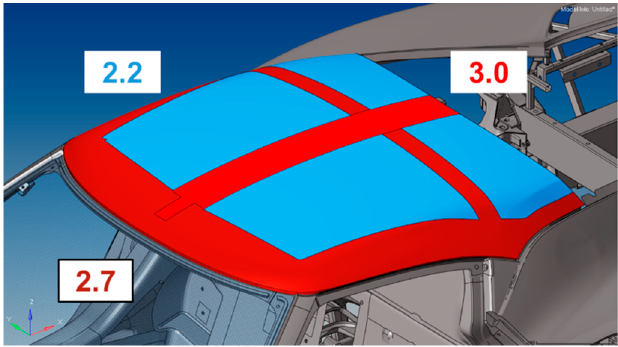
Figure 9. Fiberglass composite roof with highlight of variable thickness.